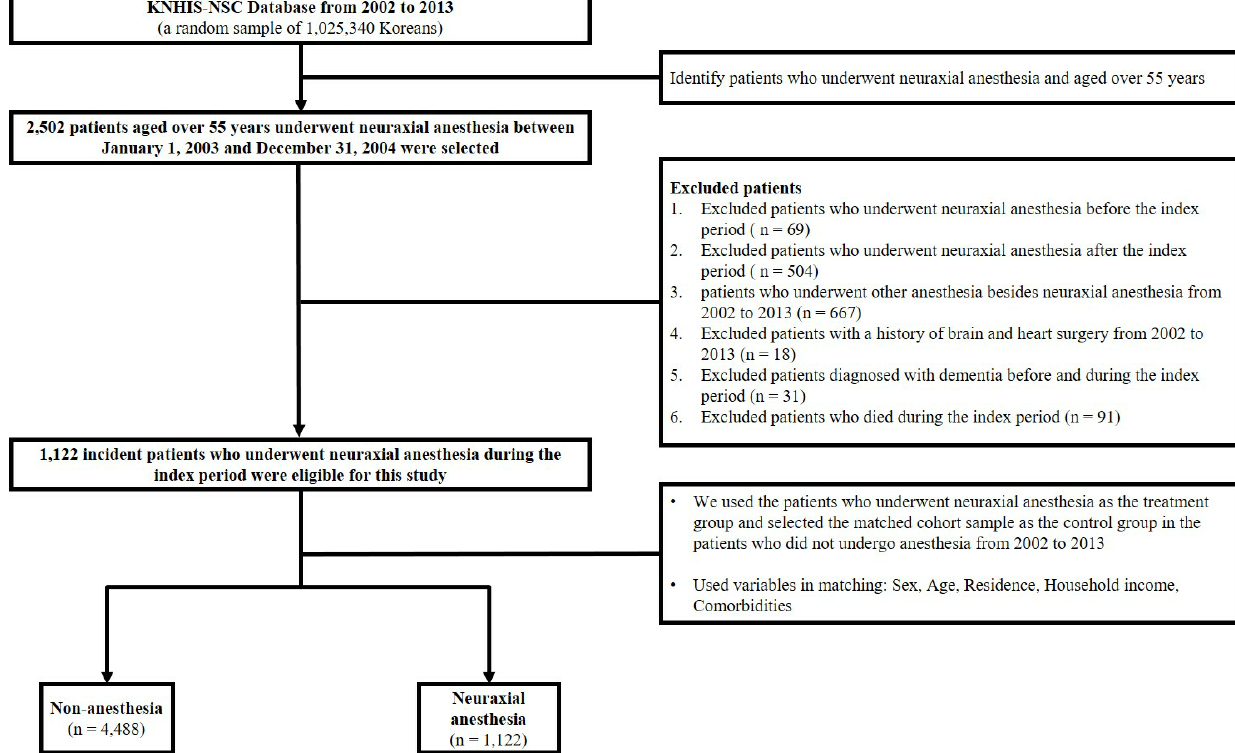
Figure 1. Schematic description of study design.